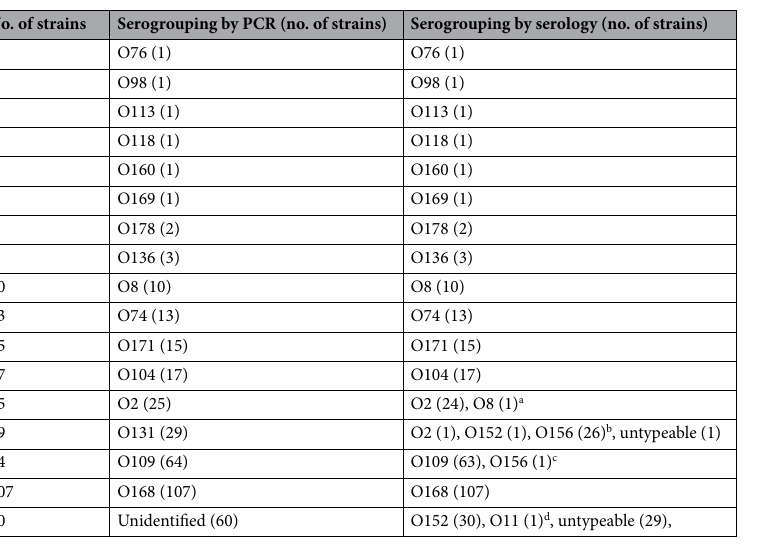
Table 4. Comparison of serogroup identification by PCR and serology of Shiga toxin gene-positive Escherichia coli strains (n = 351) isolated from feedlot cattle feces. a O8 strain was positive for O2 by PCR with primers from Iguchi et al. 38 and DebRoy et al. 29, 37 . b Strains O2 (1), O152 (1), and O156 (26) were negative by PCR for O2, O152 and O156 with primers from Iguchi et al. 38 and DebRoy et al. 29, 37 . c Strain O156 (1) was positive for O109 by PCR with primers for O109 from Iguchi et al. 38 and DebRoy et al. 29, 37 . d Strains O152 (30) and O11 (1) were negative by PCR for O152 and O11 with primers from DebRoy et al. 29, 37